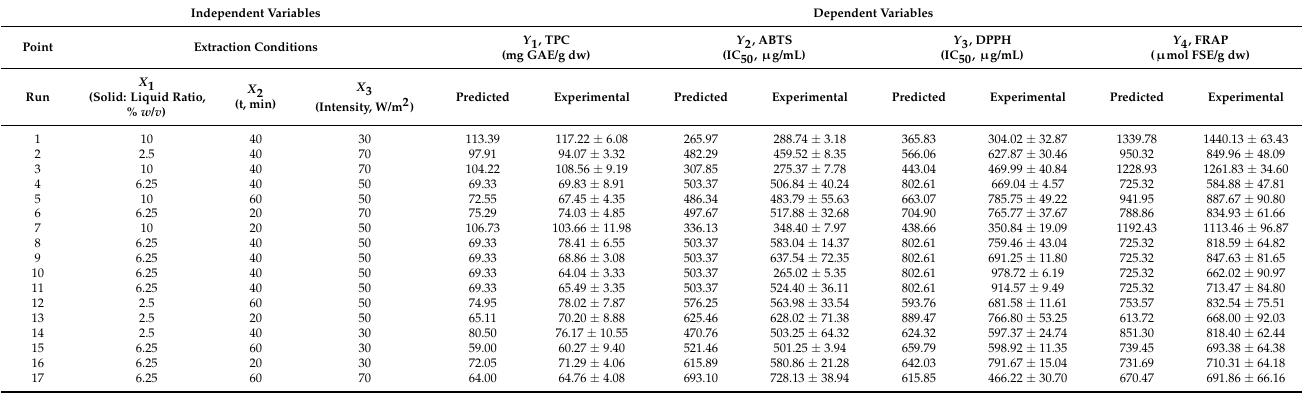
Table 1. Independent variables used for the central composite design (CCD) and predicted and experimental values of total phenolic compounds (TPC) (mg gallic acid equivalents (GAE)/g dw), ABTS (IC 50 µ g/mL), DPPH (IC 50 µ g/mL) and FRAP ( µ mol FSE/g dw) of kiwiberry leave extracts obtained by